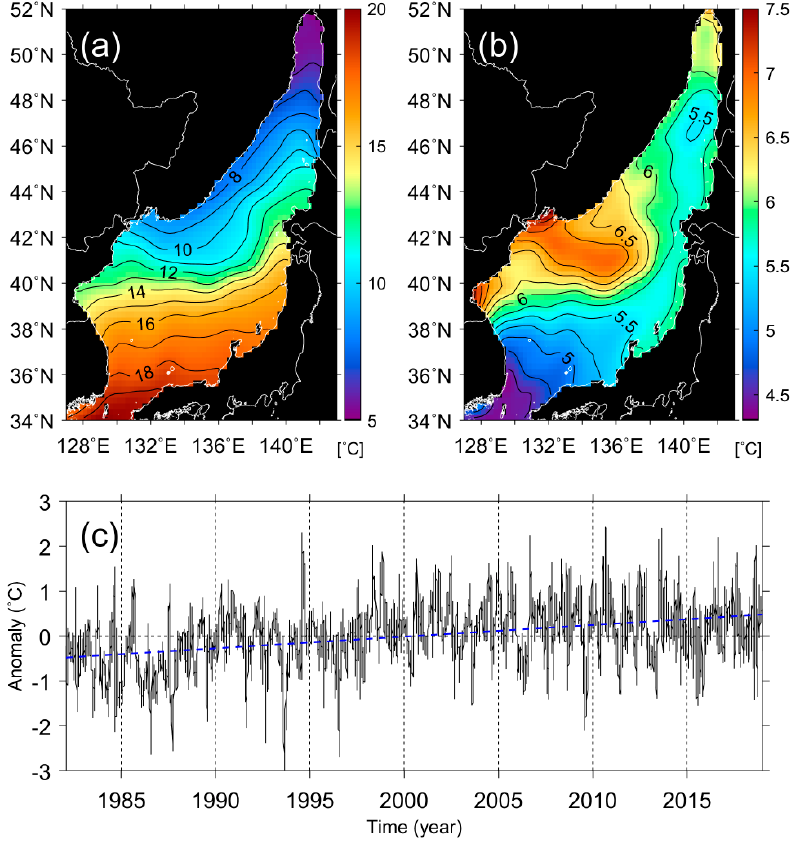
Figure 2. Spatial distribution of ( a ) mean and ( b ) standard deviation of the SST data for the observation period from 1982 to 2018 in the EJS, and ( c ) time series of spatial mean anomaly, where the blue dashed line is a least squares linear fit.